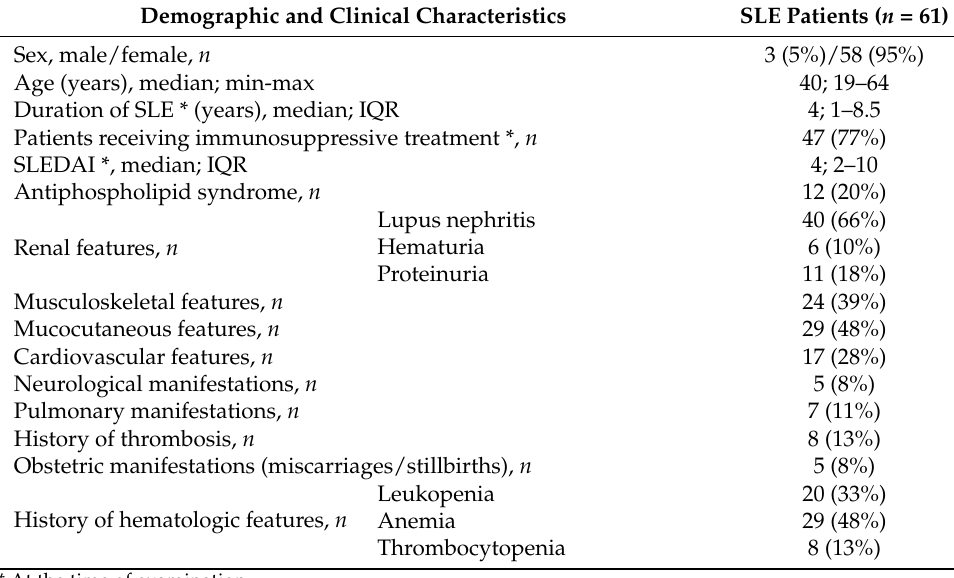
Table 3. Demographic and clinical characteristics of SLE patients enrolled in this study. Demographic and Clinical